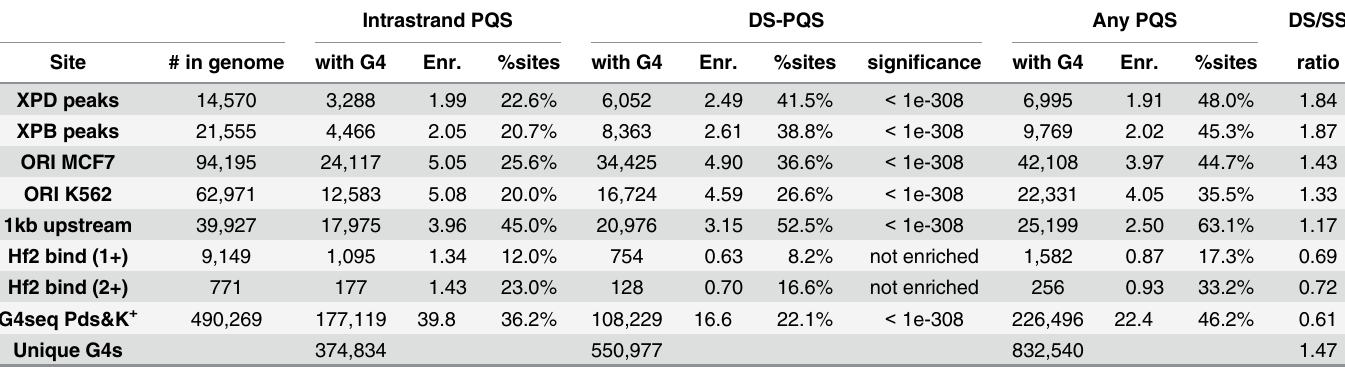
Table 2. Intrastrand and interstrand G-quadruplex forming sequences associated with functional sites in the human